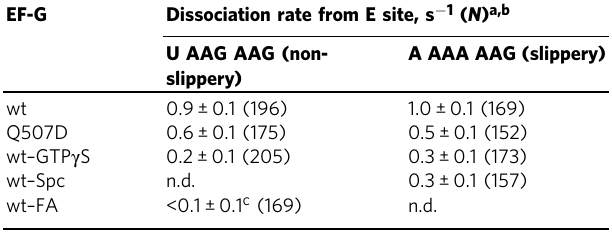
Table 2 Kinetics of deacylated tRNA Lys dissociation from the E